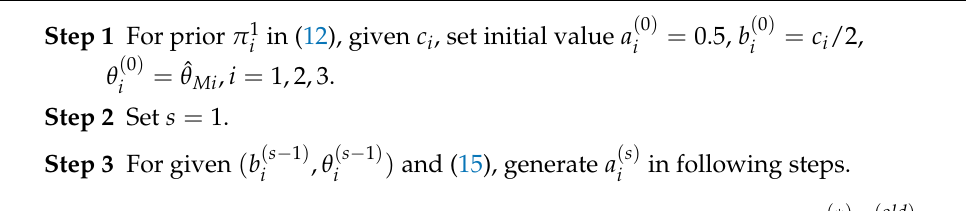
Algorithm 1: E-Bayesian interval estimation based M-H algorithm via Gibbs